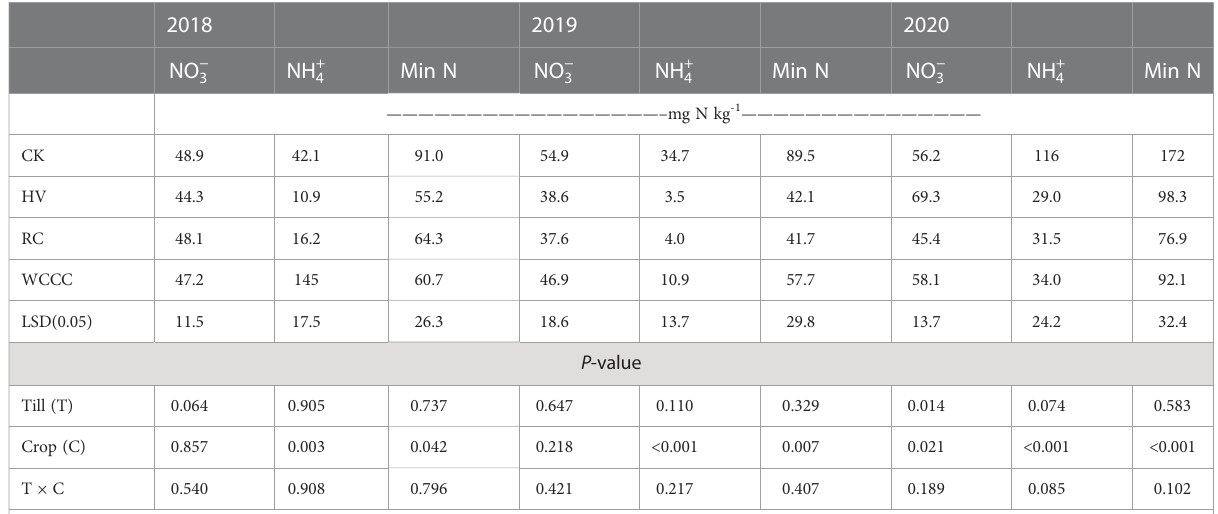
TABLE 3 Effects of cover crop species and termination-tillage method on soil mineral nitrogen concentrations in the 0-150 mm depth range at one month after corn planting each